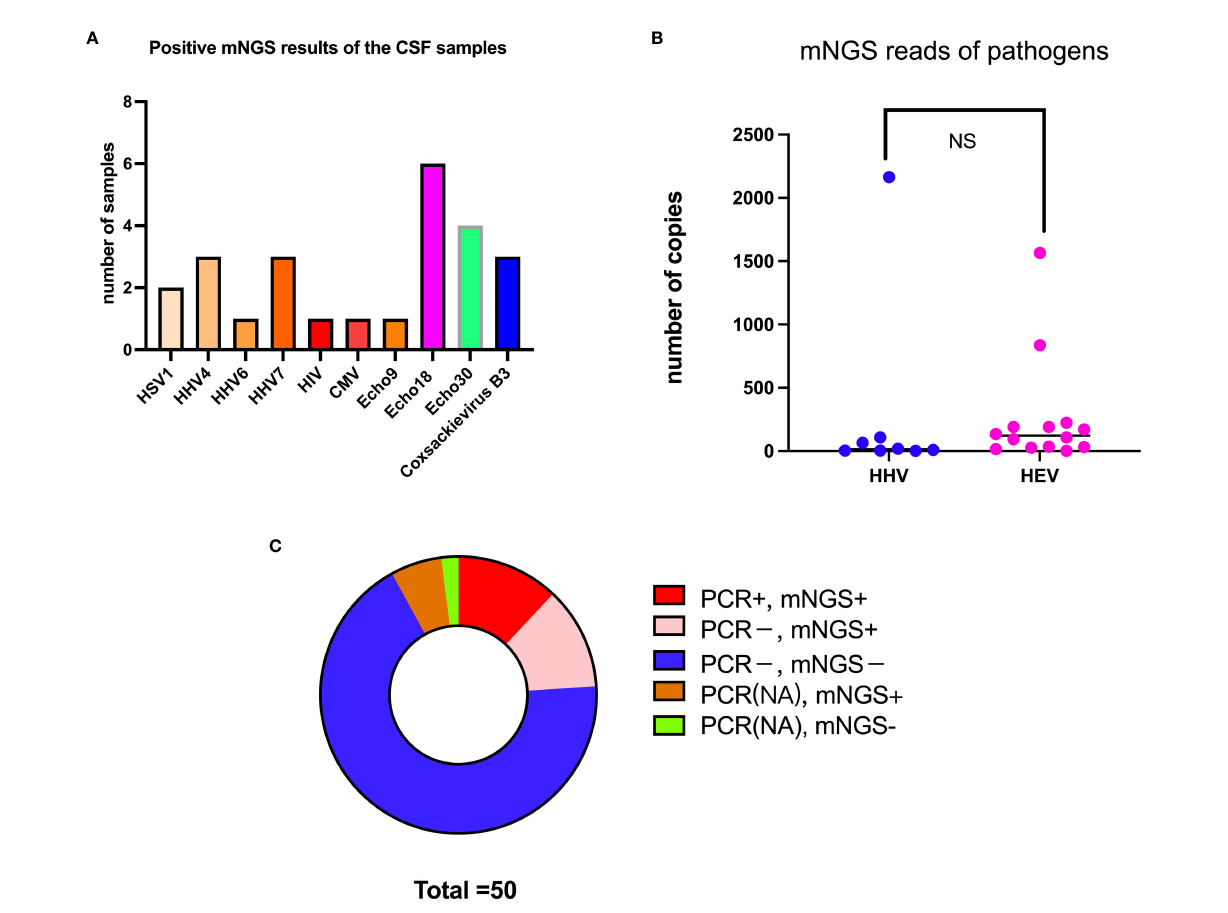
FIGURE 1 mNGS analysis results of the CSF samples. (A) Total number (besides the bars) of samples with a positive result for each pathogen (x-axis). (B) Comparison of the number of reads between HEV and HHV. (C) Comparison of detection rate between mNGS and PCR analysis. NS, no signi fi cant